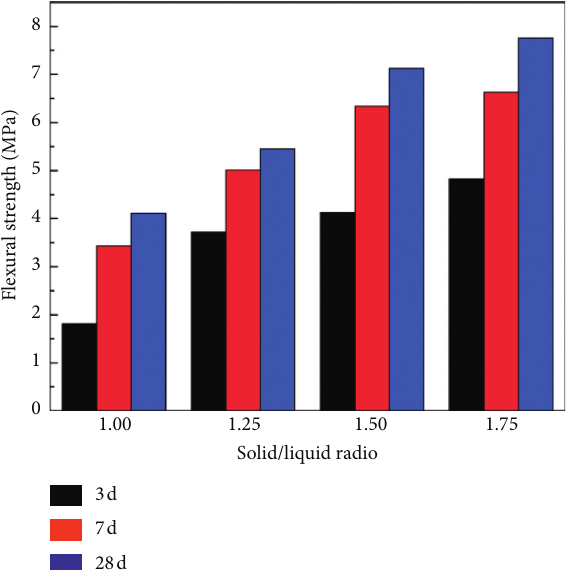
Figure 4: Influence of the solid/liquid ratio on geopolymer flexural